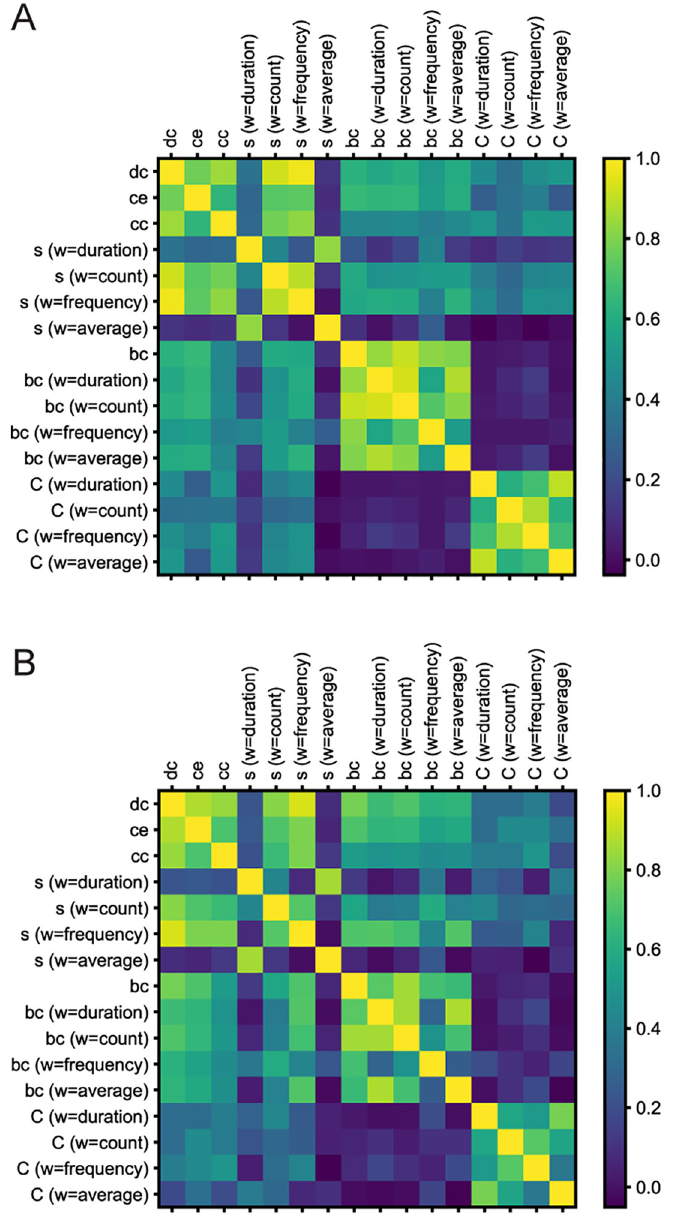
Fig 6. Node strength distribution using weights uncover more of longer interactions in the COC SINs. Strength distribution, using weight A) count and B) duration. Box plot of average values for nine CTRL SINs (n = 270 flies) grouped, which were given regular food, and eleven COC SINs (n = 330 flies) grouped, which were orally administrated 0.5 mg/mL of cocaine for 24 hours before tracking. Data are extracted from 10 minute videos using FlyTracker and analyzed using NetworkX. Statistical analysis was performed using two-sample t -tests for a difference in mean for paired samples with a p-value less than 0.05 taken as significant, presented in an S1 Table.